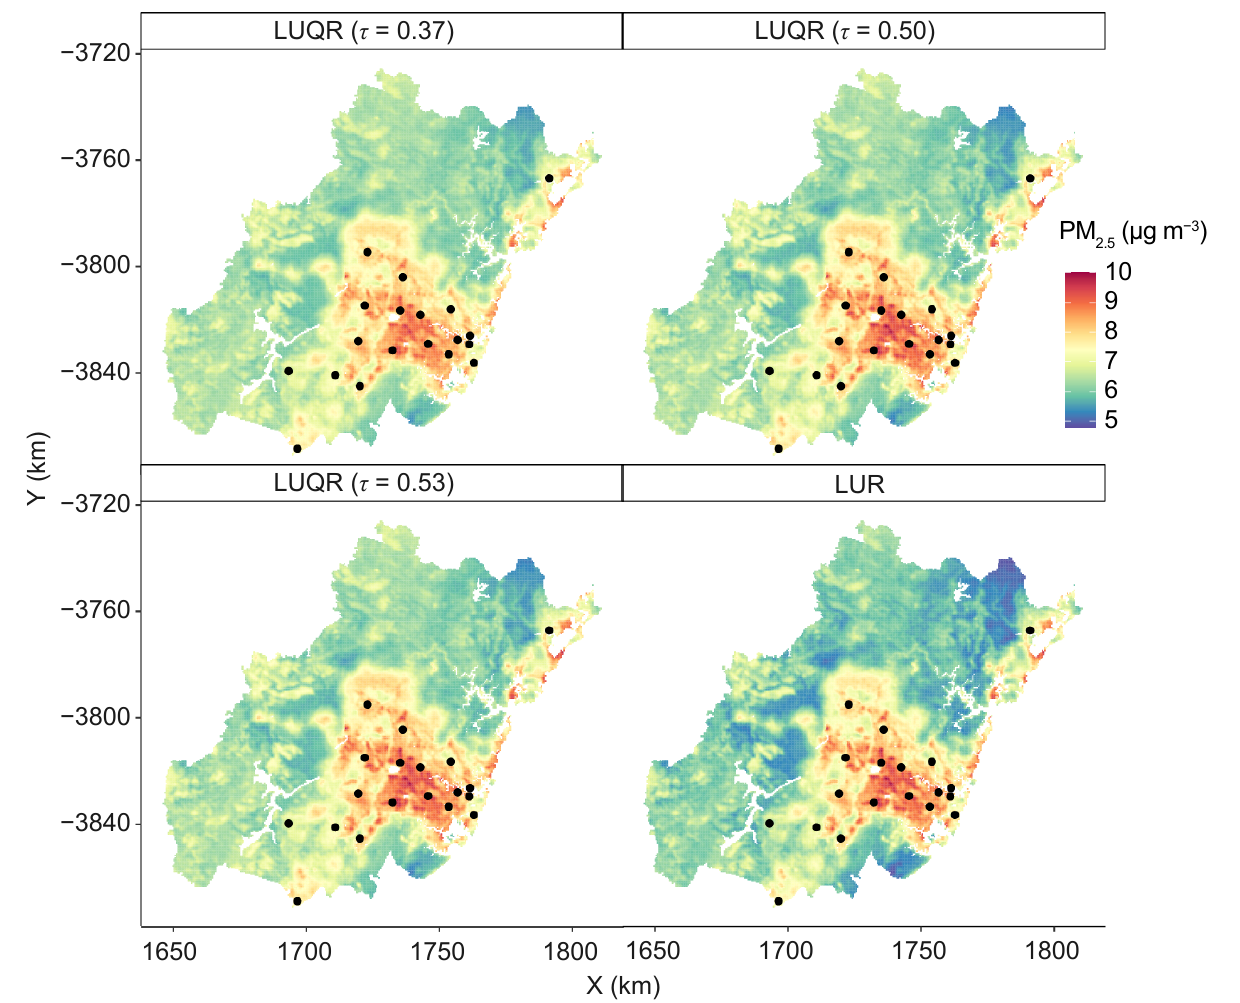
Figure 6. Spatial predictions of PM 2.5 concentrations using LUQR ( τ = 0.37), LUQR ( τ = 0.50), LUQR ( τ = 0.53) and LUR